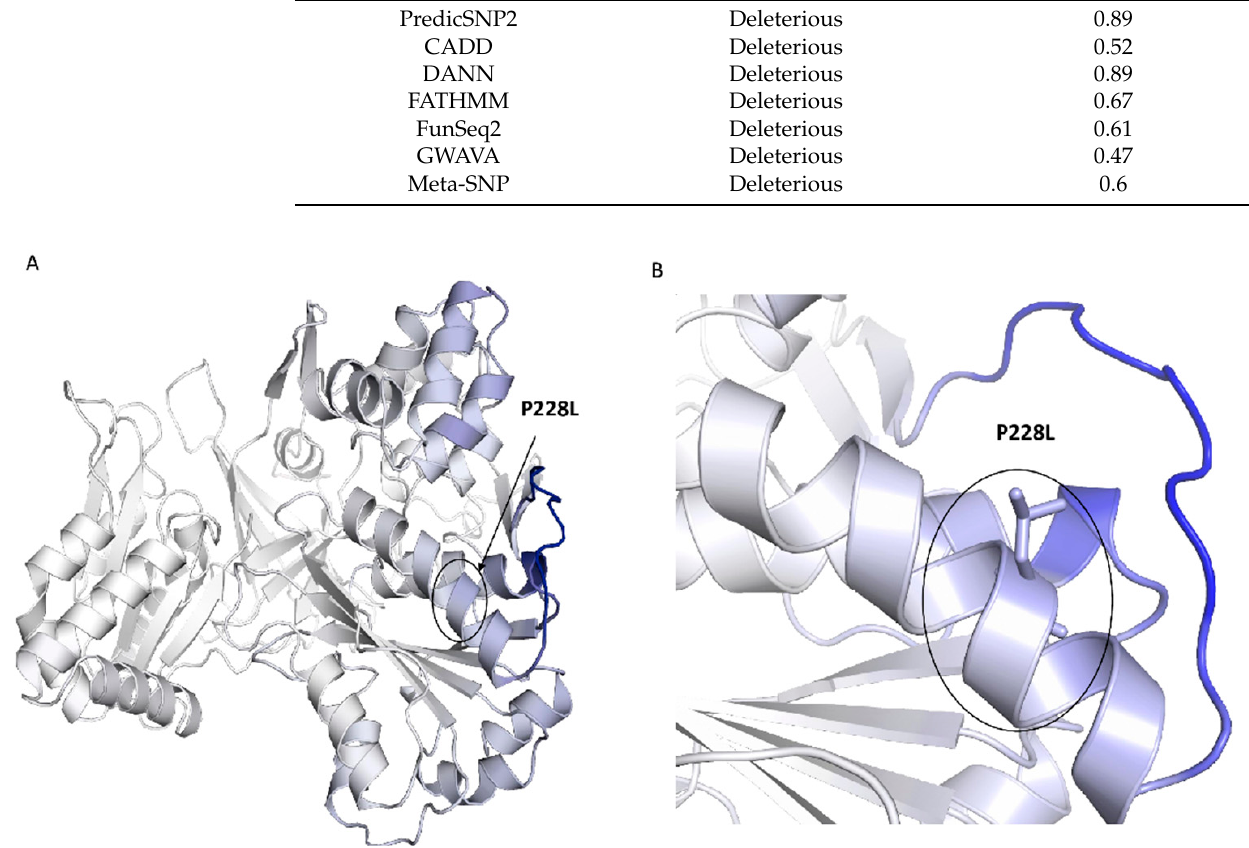
Figure 4. Visual representation of the vibrational entropy difference ( ∆∆ S) between POR wild type and P228L structures ( ∆∆ S Vib : − 0.904 kcal · mol − 1 .K − 1 ) calculated with ENCoM ( A ). ( B ) Mutant P228L de- creased the flexibility of the molecule. Amino acids are coloured according to the vibrational en- tropy change upon mutation. Blue represents a rigidification of the structure and red represents a gain in flexibility.